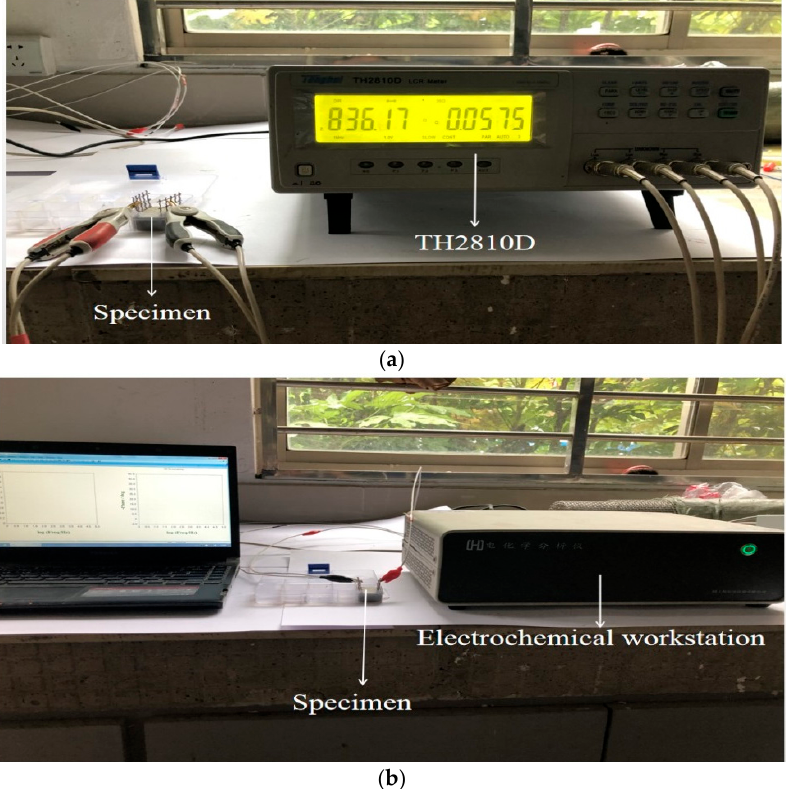
Figure 1. Electrical parameters measurement: ( a ) Electrical resistance measurement; ( b ) Alternating current (AC) impedance spectroscopy.